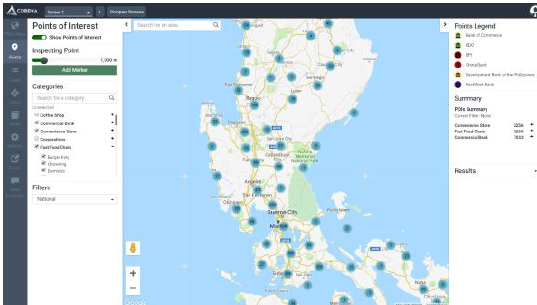
Figure 3. Points of interest clustering according to zoom level, with legend and summary statistics.